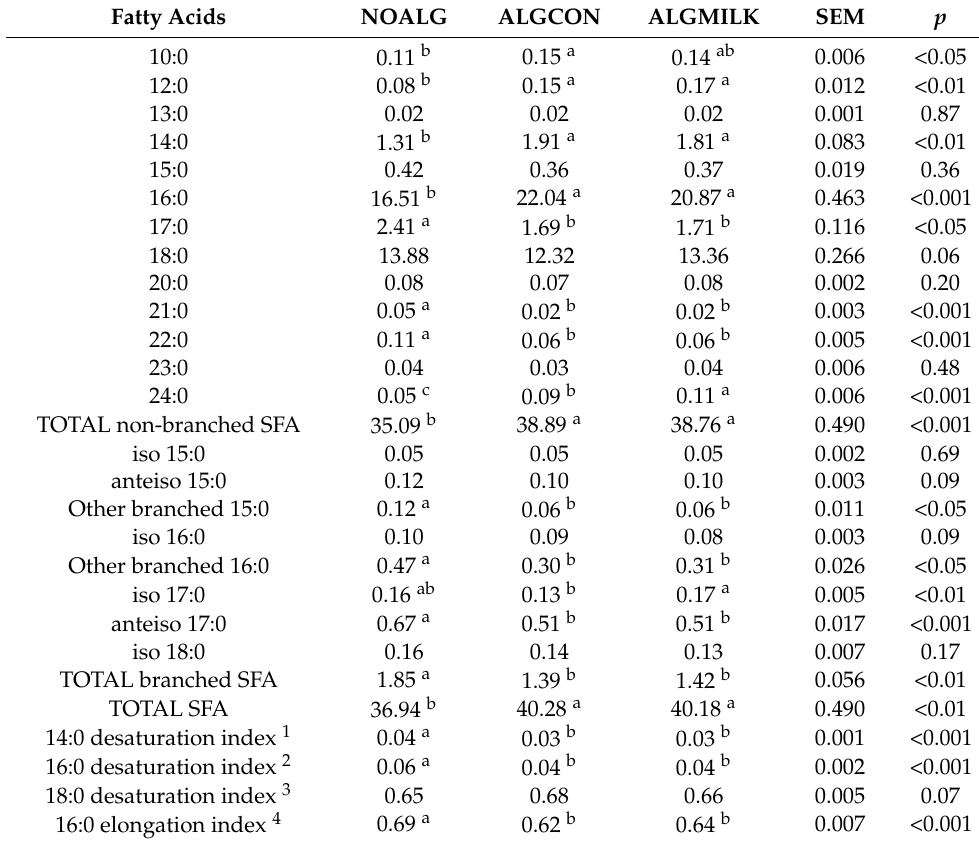
Table 2. Saturated fatty acid (SFA) profile (g/100 g of total fatty acid methyl esters) in intramuscular fat of feedlot lambs fed a conventional diet alone (NOALG) or feedlot lambs with competent reticular groove reflex fed the same diet supplemented with 2.5% of algae meal, either mixed in the concentrate (ALGCON) or in the milk replacer